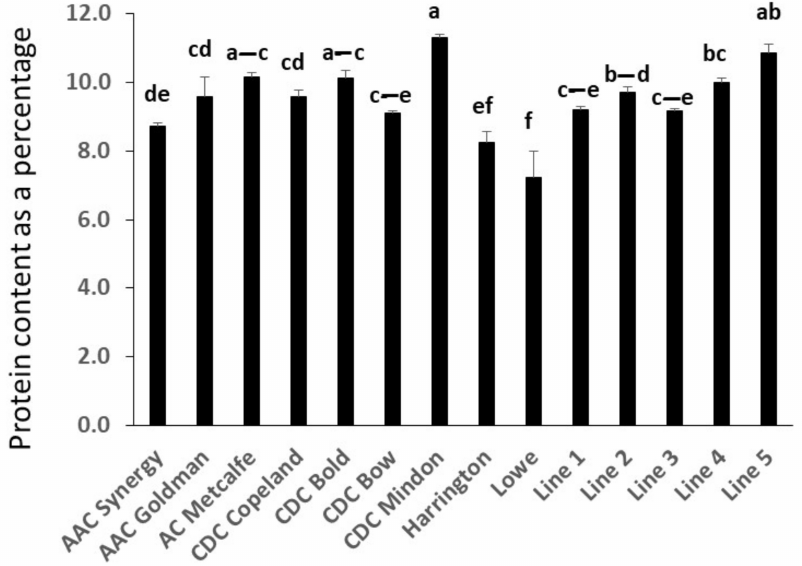
Figure 2. Protein content in tested barley grain samples assessed by LECO protein analyzer. Error bars represent the standard deviation of three replicates each. Values sharing the same letter/s are not significantly different at the level ≤ 0.05 using Tukey